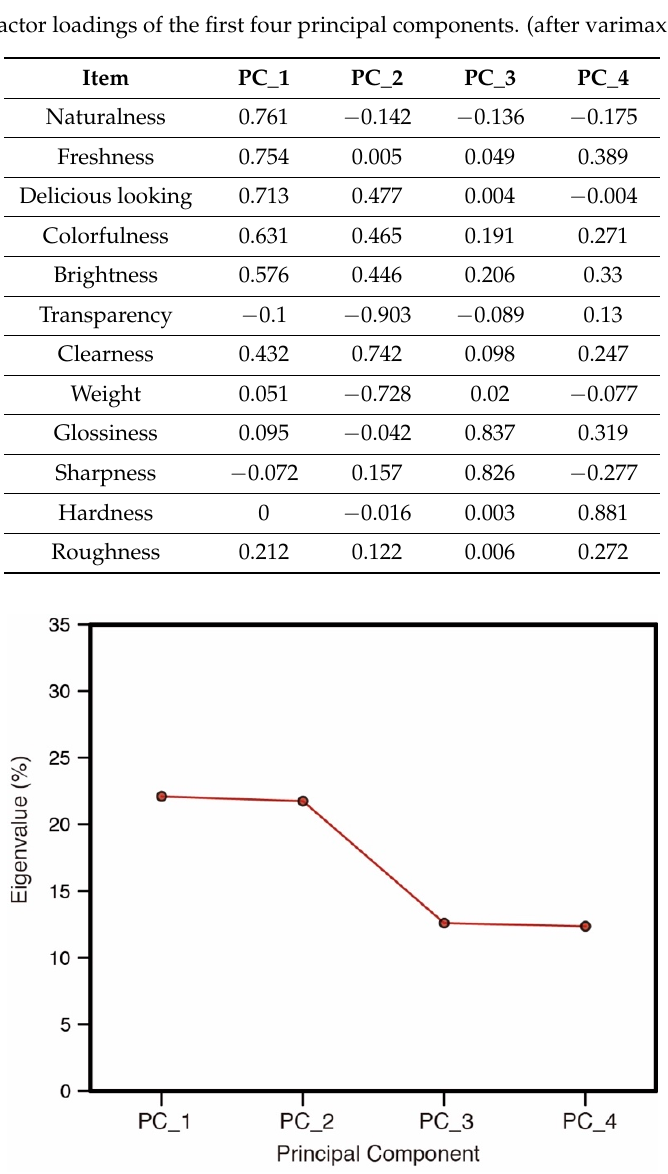
Table 2. Factor loadings of the first four principal components. (after varimax rotation).